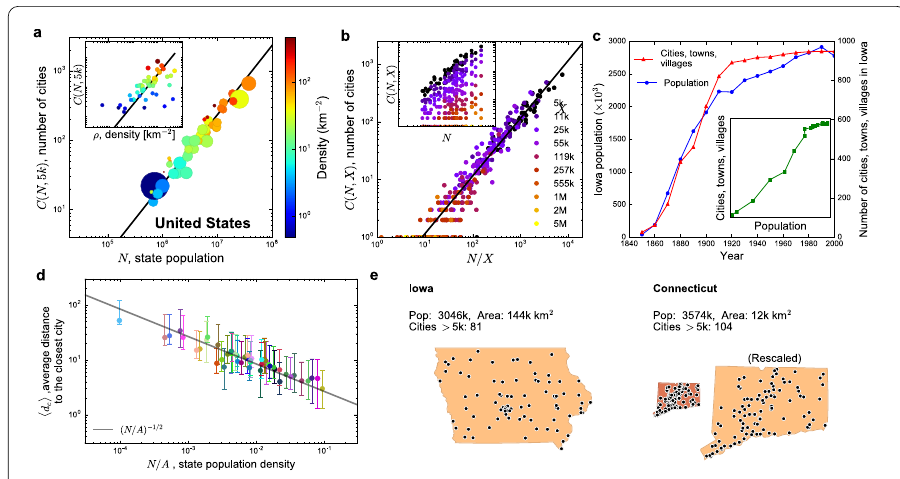
Figure 3 Consequences of Heaps’ law. ( a ), The number of cities with more than 5000 inhabitants in the Unites States is proportional to the state’s population, corr( C , N ) = 0.95. The correlations with area (0.04) and population density (–0.08, see inset) are negligible, as illustrated by the following pairs of states with similar area or density and very different number of cities: Alaska ( A = 1.5M km 2 , C (5 k ) = 22) vs Texas ( A = 0.7M km 2 , C (5 k ) = 392), and Rhode Island ( ρ = 393 km –2 , C (5 k ) = 35) vs New Jersey ( ρ = 467 km –2 , C (5 k ) = 316). ( b ), Combining the result from panel ( a ) with Zipf’s law it is possible to estimate the number of cities with more than X inhabitants in a country with population N as C ( N , X ) ∼ N / X ; Heaps’ law. As a consequence, the scattered cloud of points resulting when plotting C ( N , X ) against N for various X ’s in the range 5 · 10 3 – 5 · 10 6 (inset) collapses on a straight line when C ( N , X ) is plotted against the ratio N / X . ( c ), Historical records of the number of incorporated places ( C , red triangles) and the state population ( N , blue circles) in Iowa from 1850 to 2000 (source: State library of Iowa, state data center). The similar growth rates of C and N entail the validity of Heaps’ law C ∼ N during the 150-year period (inset). ( d ), The average distance to the closest city in the United States scales as the inverse of the square root of the state’s population density (here all cities with more than 5000 inhabitants are considered). The asymmetric error bars denote the standard deviations above and below the average. ( e ), Illustration of the relationships between total population, number of cities, and their average distance in Iowa and Connecticut. In agreement with Heaps’ law, C ∼ N α , Iowa and Connecticut have similar populations and a similar number of cities with more than 5000 inhabitants, despite Connecticut having one-twelfth the area of Iowa. In agreement with Equation (2), cities in Connecticut are closer than cities in Iowa because of the higher population density in Connecticut. By rescaling distances such that Connecticut’s area becomes equal to Iowa’s area, the two states would have the same population density